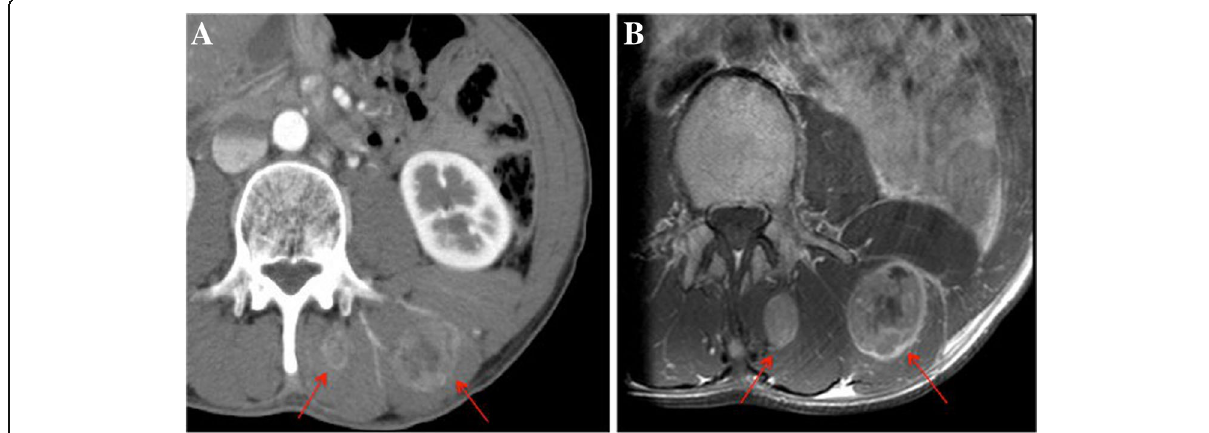
Fig. 2 a An abdominal computed tomography scan revealed a solid mass (arrows), measuring 40 mm × 30 mm, in the left latissimus dorsi muscle. b A contrast-enhanced magnetic resonance imaging showed extensive peritumoral enhancement